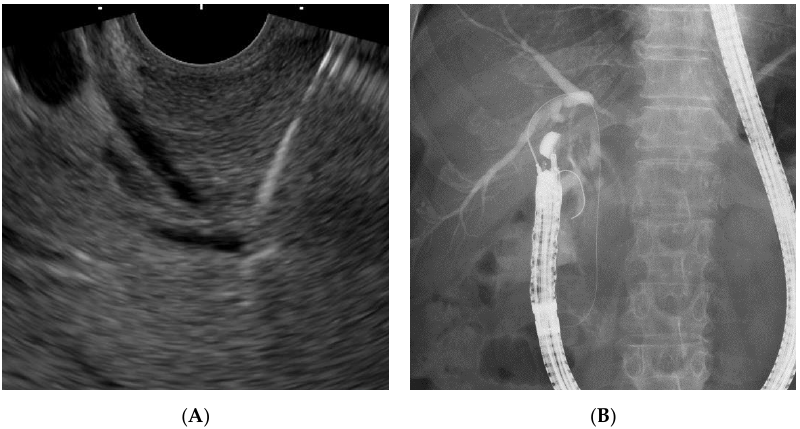
Figure 4. The right intrahepatic bile duct/duodenal bulb (RIHBD/D1) route. Endoscopic ultrasound